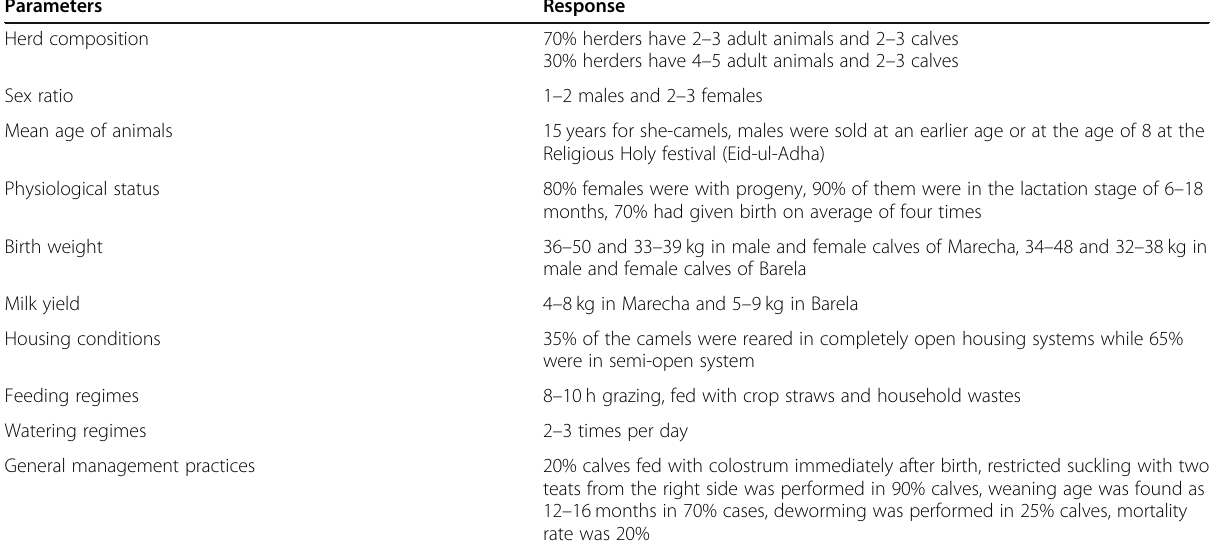
Table 1 Productive parameters and herders ’ response ( N = 200) from the study area